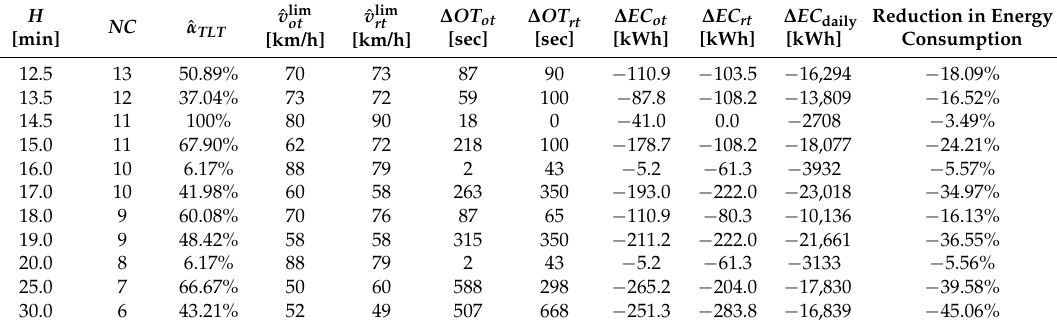
Table 7. Energy saving optimization in the case of 97.5th